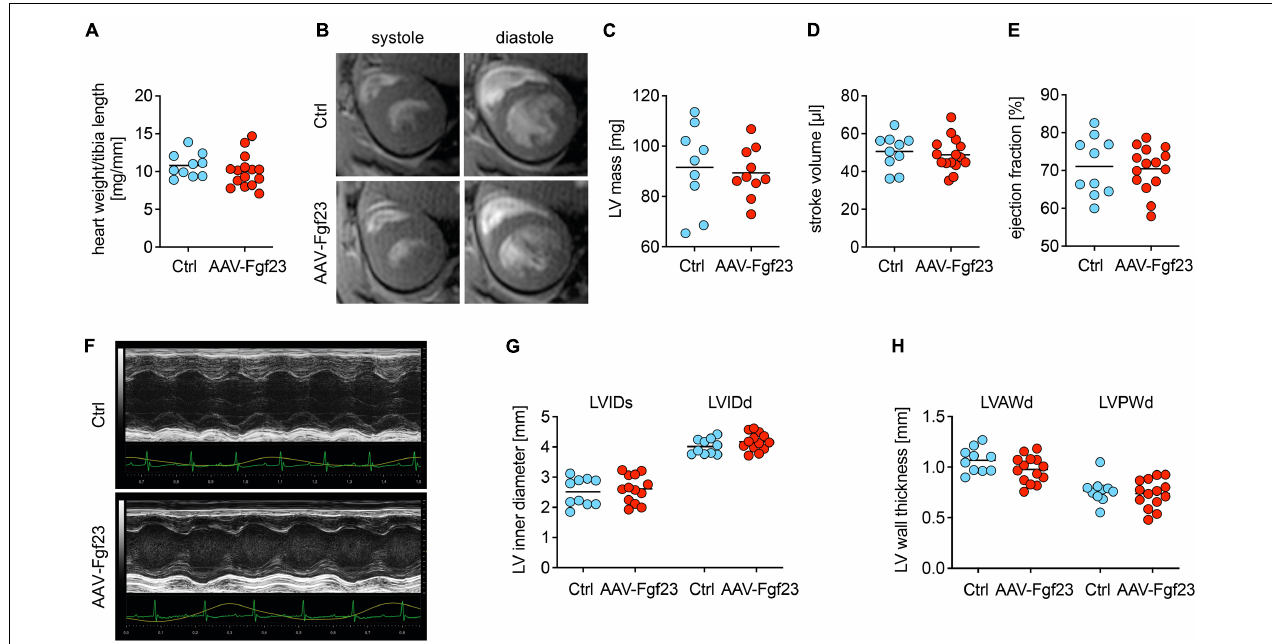
FIGURE 4 | Chronic intra-cardiac Fgf23 synthesis does not impair cardiac function in unchallenged mice. (A) The heart weight to tibia length ratio is not increased in AAV-Fgf23 mice compared to Ctrl. (B) Representative cross-section MRI images of an AAV-Fgf23 and Ctrl mouse during systole and diastole. (C–E) Analyzed by MRI, left ventricular (LV) mass, stroke volume, and ejection fraction show no significant differences in AAV-Fgf23 mice compared to Ctrl. (F) Representative PLAX M-mode echocardiography images of an AAV-Fgf23 and Ctrl mouse. (G,H) In echocardiography, LV inner diameter during systole and diastole (LVIDs/d) and LV wall thicknesses during diastole (LV anterior wall, LVAW; LV posterior wall, LVPW) are not altered in AAV-Fgf23 mice compared to Ctrl. Data are given as scatter dot plots with means; n = 9–15 mice per